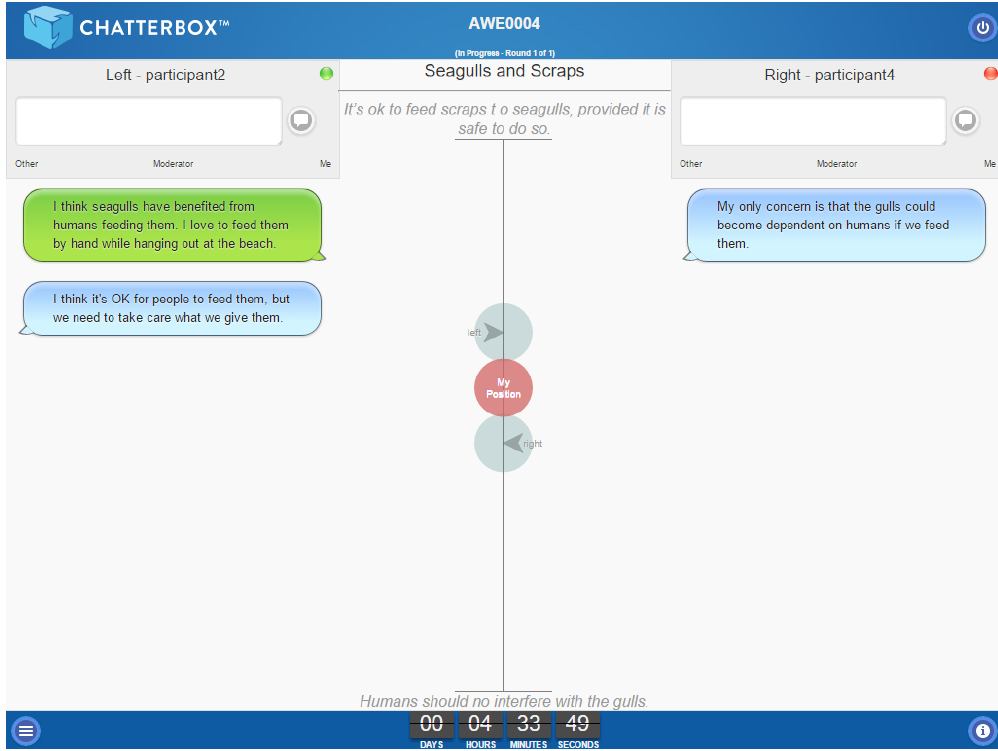
Figure 2. A screen grab from an introductory video to Chatterbox™, available on the One Welfare portal: http://onewelfare.cve.edu.au/chatterbox.